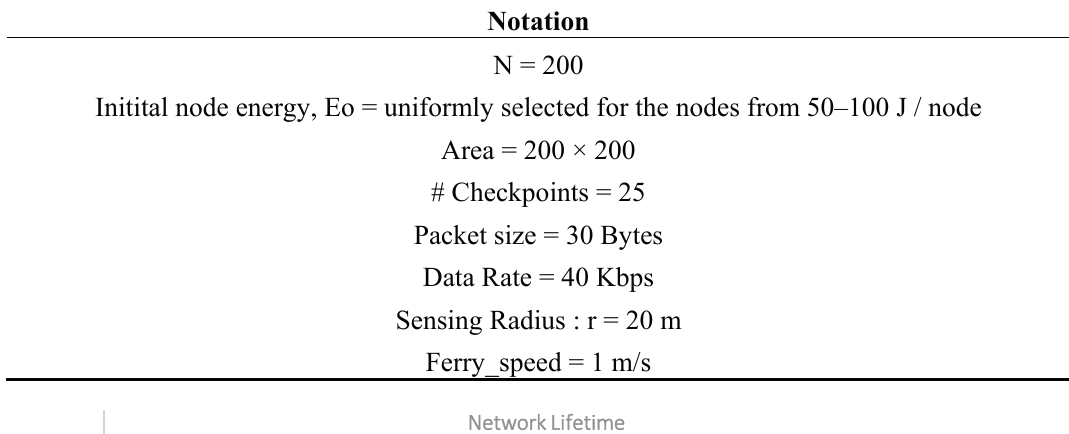
Table 6. Parameters used in the simulation to compare FNRCA to [21,22].